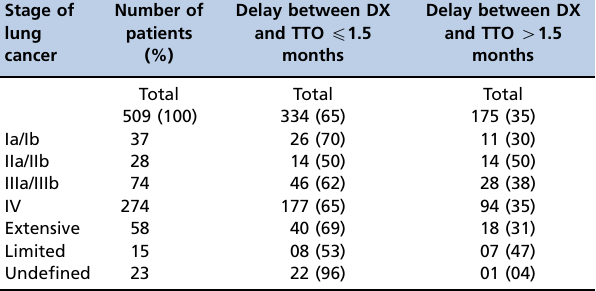
Table 2 - Stage of lung cancer with respect to time (months) from the date when the patient was diagnosed with cancer (DX) to the starting date of treatment (TTO), showing the number of patients at each stage according to the different